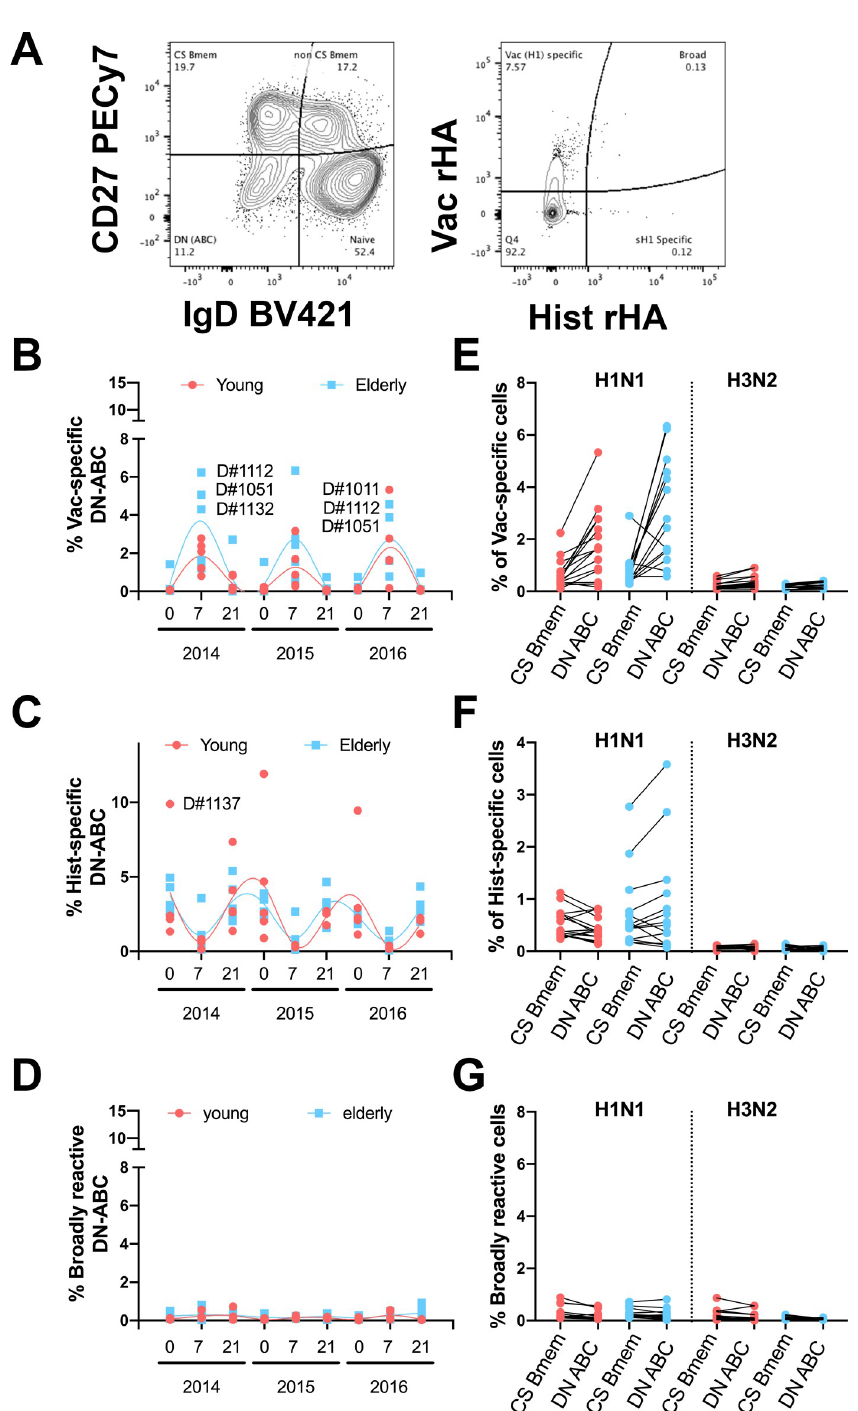
Fig 7. Frequency of rHA-reactive DN-C in young and elderly participants. A) Representative gating strategy to quantify rHA-specific DN-C in the peripheral blood of vaccinated participants. B-D) Percentage of vaccine-specific (B), historical-specific (C) and broadly reactive (D) DN-C in young adult (red) and elderly (blue) participants vaccinated for three consecutive years. E-G) Frequency of H1N1 and H3N2 vaccine-specific (E), historical-specific (F), and broadly reactive (G) B-cells in the CS-Bmem or DN-C compartment in young adult and elderly participants 7 days after vaccination.